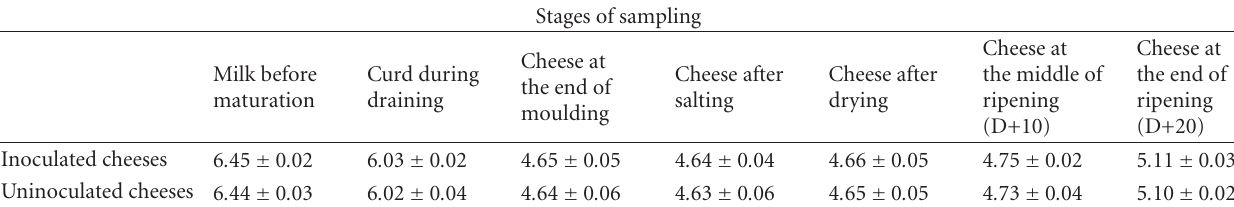
Table 4: Changes in pH values during cheese